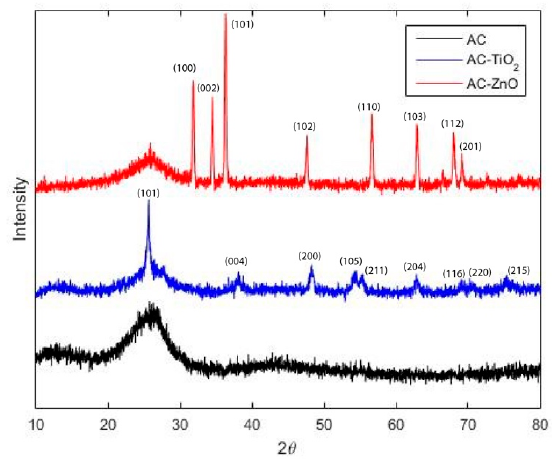
Figure 2. Powder X-ray diffraction (PXRD) patterns.